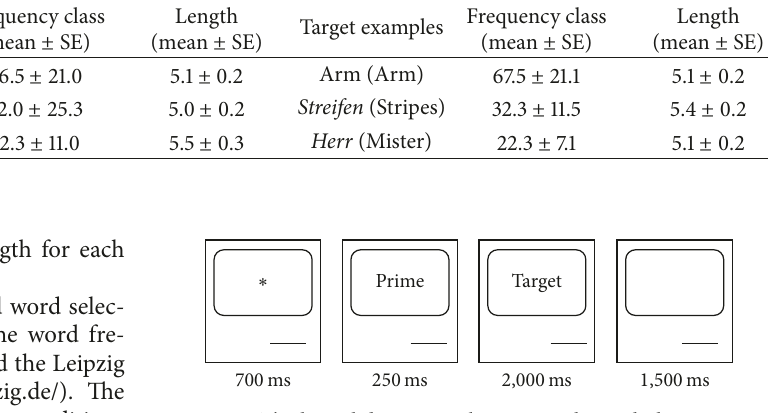
Figure 1: The lexical decision task. Prior to the trial, the computer screen was blank. A trial started with a fixation point ( ∗ ) presented for 700 ms followed by presentation of the prime for 250 ms which was immediately succeeded by the presentation of the target word. The target was displayed for 2 s, after which the screen went blank for 1.5